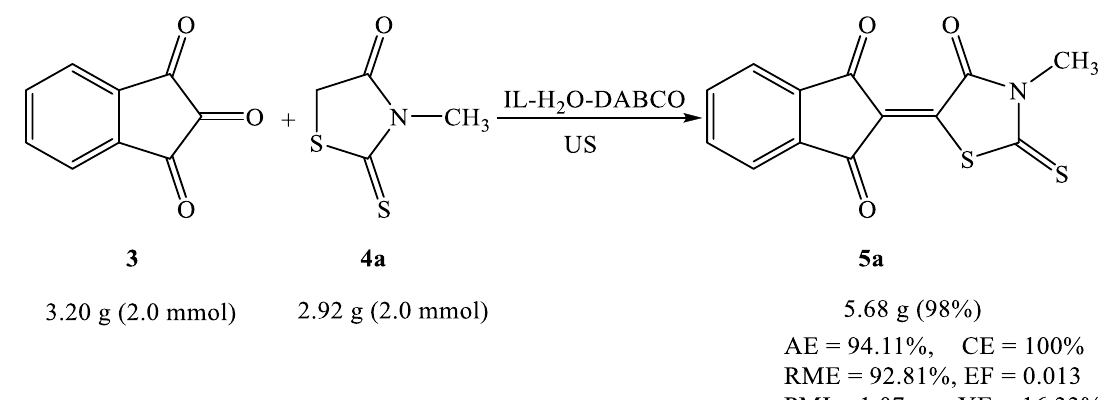
Scheme 7. Scaled up the preparation of derivative 5a .